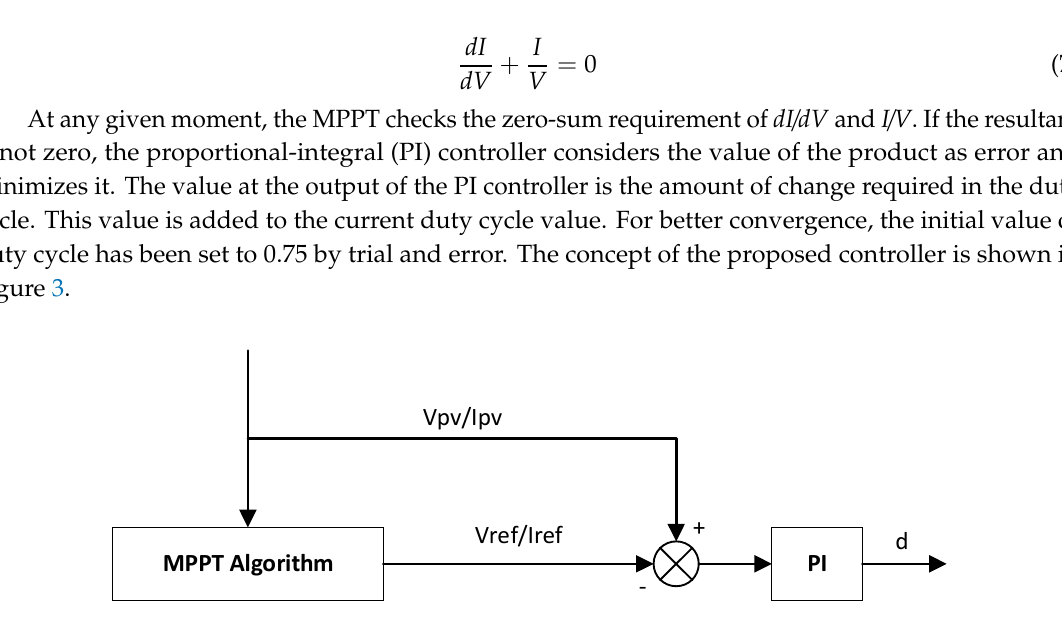
Figure 3. Block diagram of maximum power point tracking (MPPT) model.